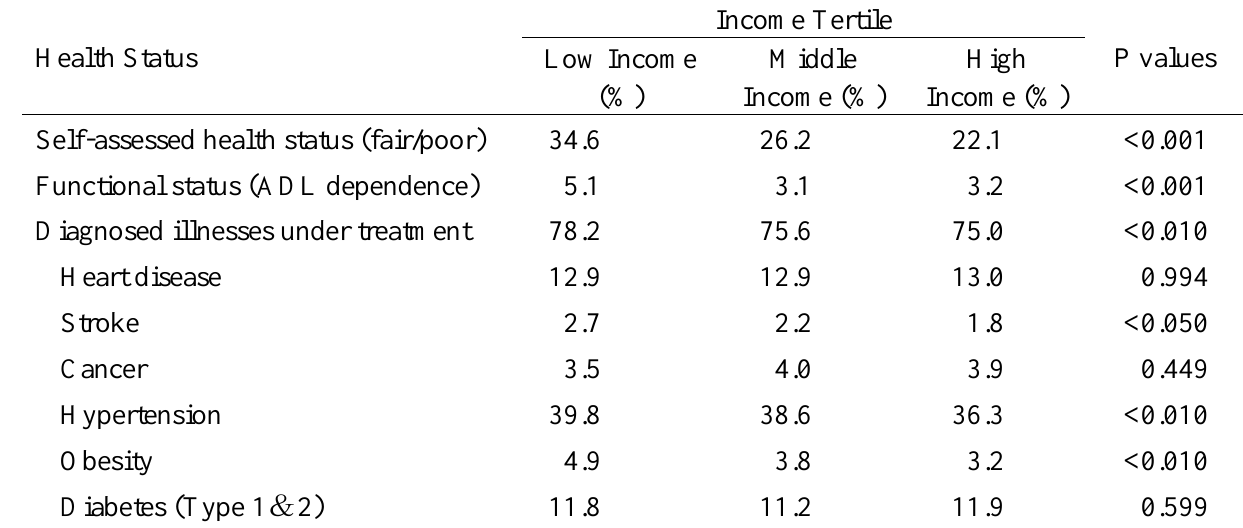
Table 1. Association between health status and income (N =